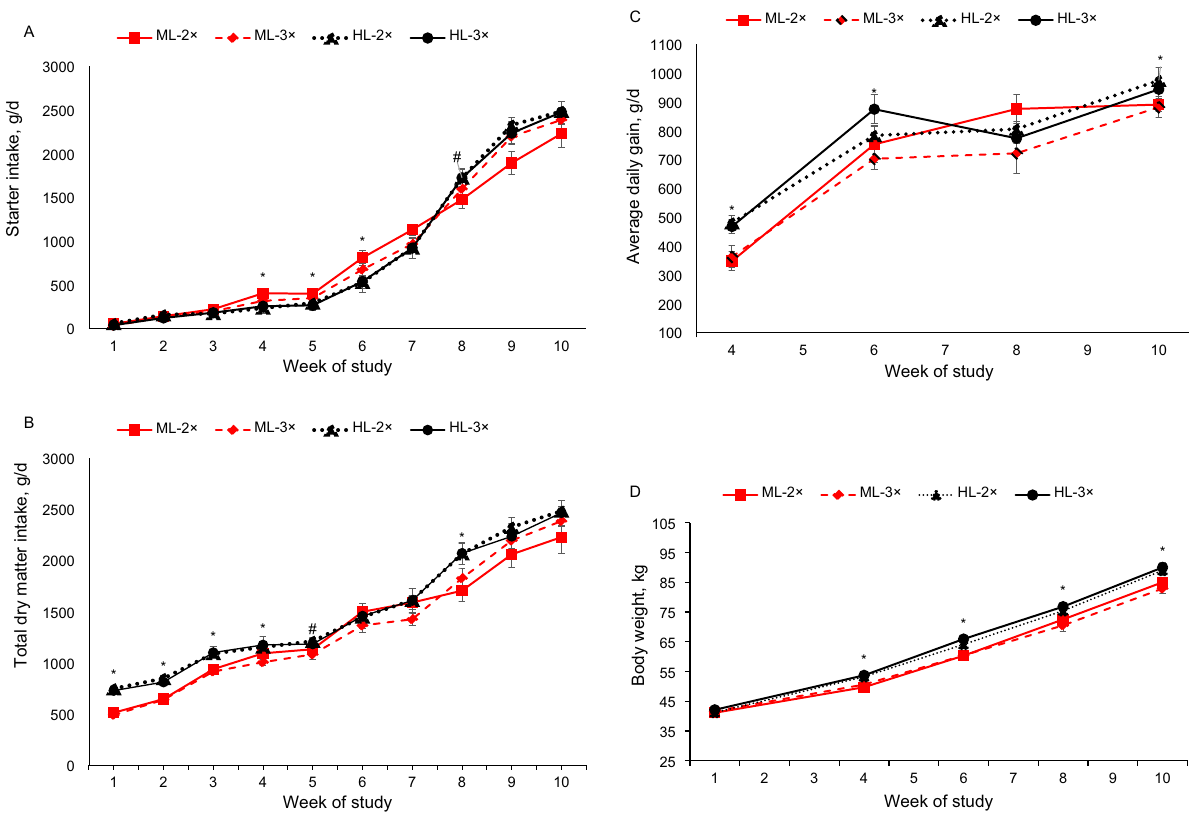
Figure 2. Starter feed intake ( A ), total dry matter intake ( B ), average daily gain ( C ), and body weight ( D ) of calves with one of the following treatments: calves fed medium milk level and 2 × frequency (medium-2 × ; red filled square), calves fed medium milk level and 3 × frequency (medium -3 × ; red filled rhombus), calves fed high milk level and 2 × frequency (High-2 × ; black filled triangle), and calves fed high milk level and 3 × frequency (High3 × ; black filled circle) during the different week of study. Error bars represent the SEM at each point. For each time point, *denotes significant differences ( P < 0.05), # denotes trend differences (0.05 < P < 0.10) for level milk